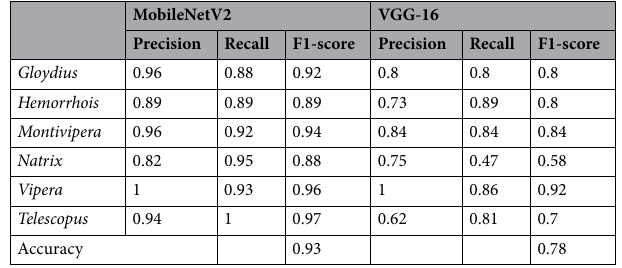
Table 5. Accuracy result of MobileNetV2 and VGG-16 model for snake image classification.